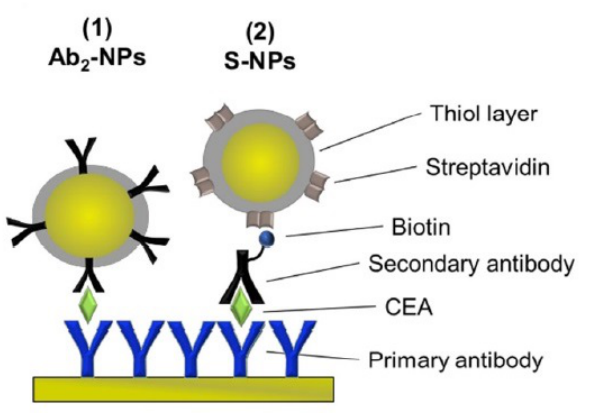
Figure 4. Schematic illustration of the sandwich assays using two types of functionalized NPs for the detection of CEA.The primary antibody is immobilized on the sensor surface. After the capture of the analyte (CEA), the signal is enhanced by using (1) NP functionalized with the secondary antibody specific for CEA (Ab2-NPs) or (2) secondary antibody and NPs functionalized with streptavidin (S-NPs) binding to the biotinylated Ab2B. (Reproduced from reference [64]).